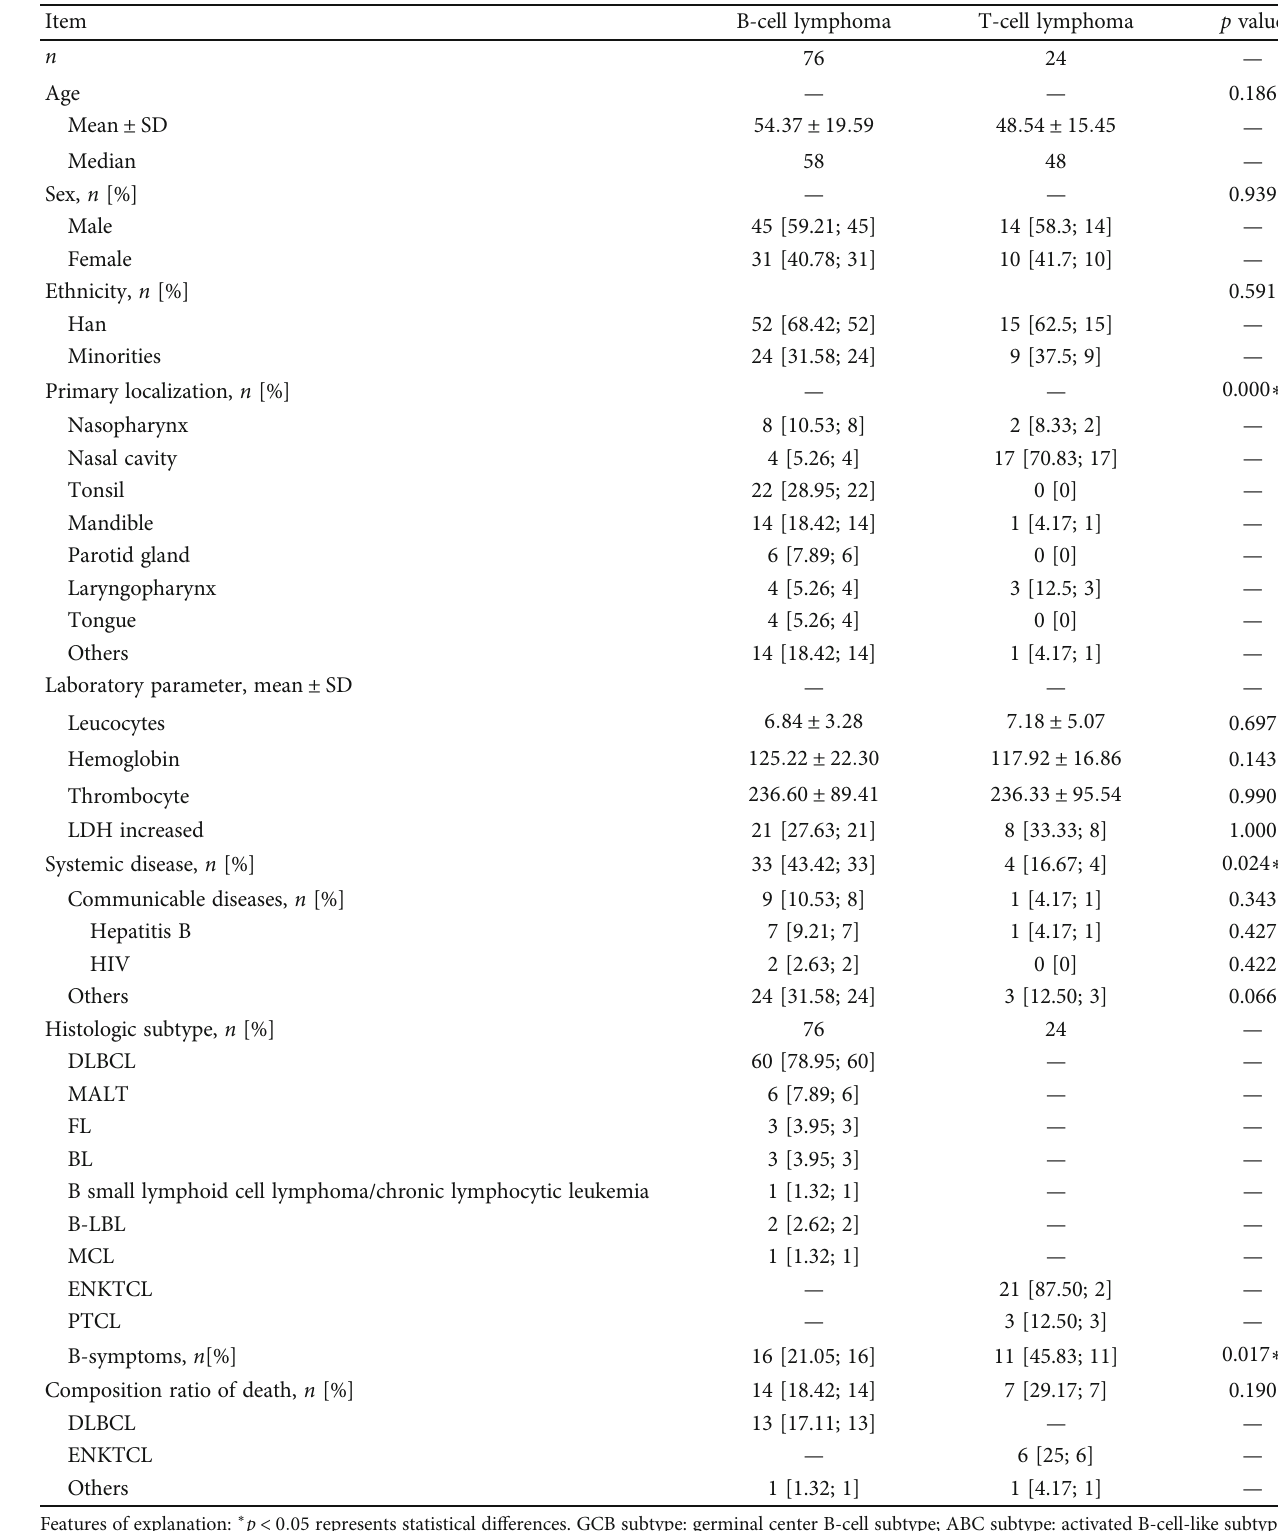
Table 2: Frequency of histologic types of head and neck lymphoma including epidemiology, symptomatology, disease manifestations, localization, and laboratory fi